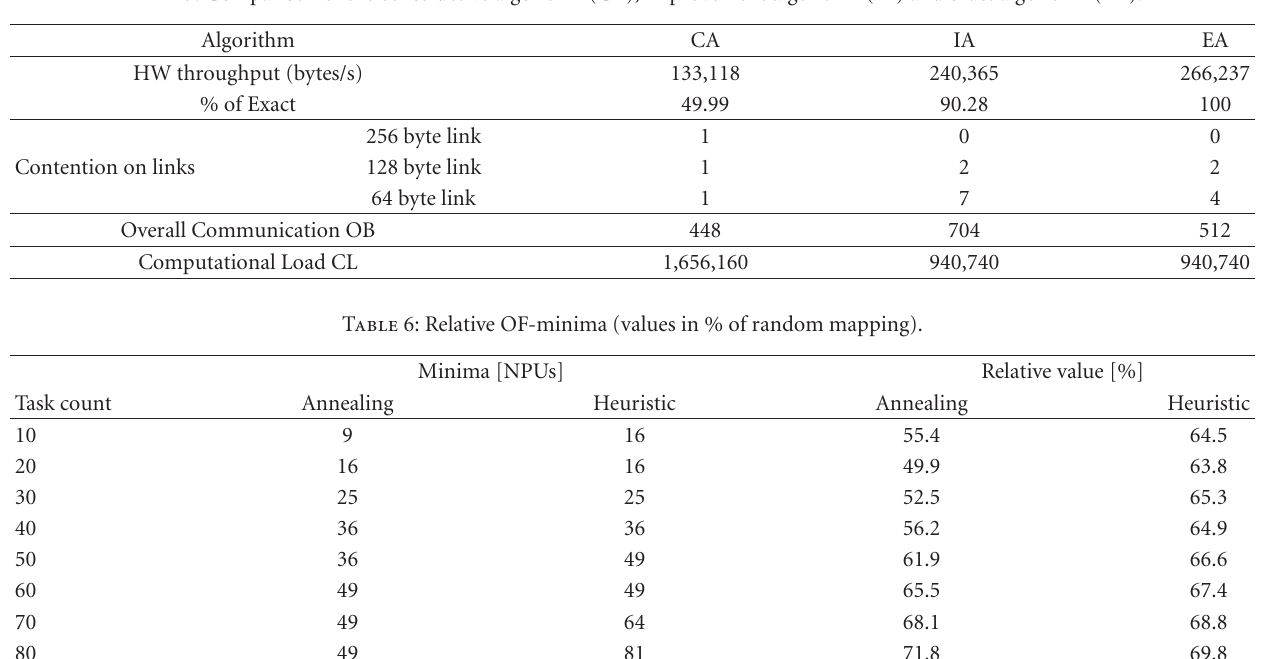
Table 5: Comparison of the constructive algorithm (CA), improvement algorithm (IA) and exact algorithm (EA).